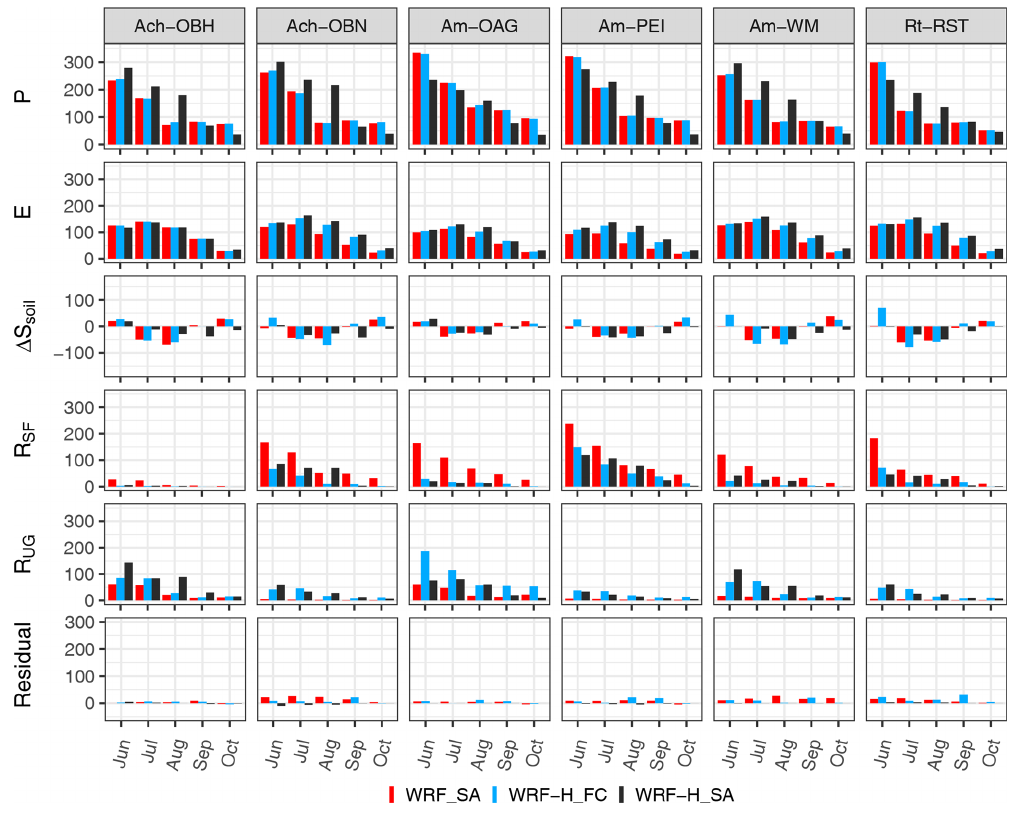
Figure 14. Monthly water budgets in millimeters for subcatchments of the Ach, Ammer (Am), and Rott (Rt). P : precipitation; E : evapotran- spiration; (cid:49)S soil : soil water storage change; R sf : surface runoff; R UG : underground runoff (groundwater recharge). WRF_SA: standalone WRF model; WRF-H_FC: fully coupled WRF-Hydro model; WRF-H_SA: observation-driven WRF-Hydro standalone